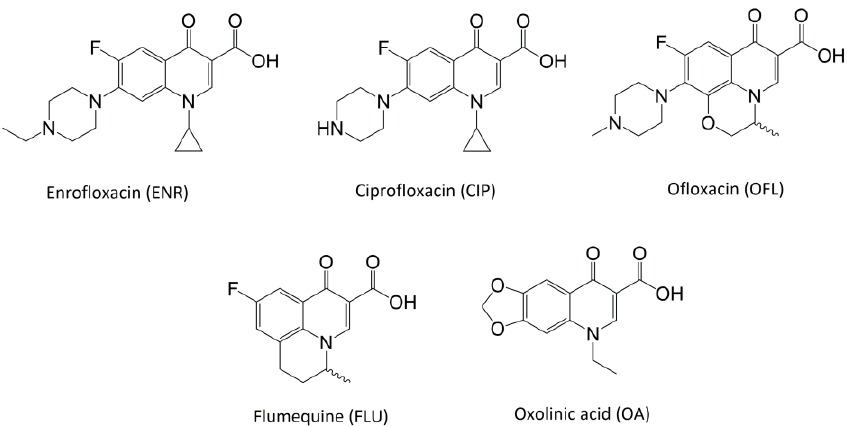
Figure 1. Studied (fluoro)quinolones in this work.